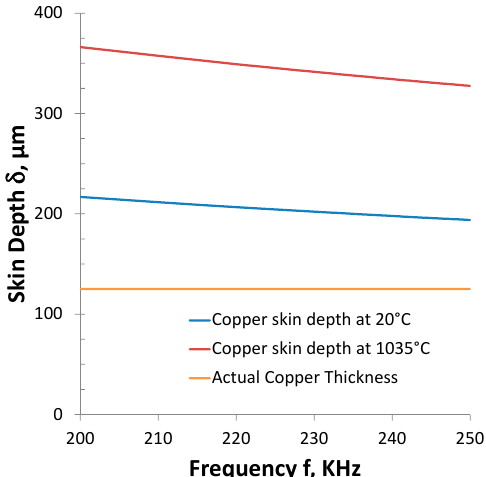
Figure 2. Actual copper thickness as compared to calculated skin depths, at di ff erent operating frequencies.